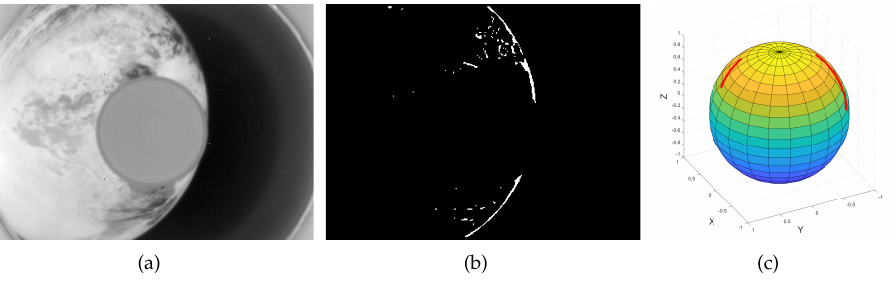
Figure 9. ( a ) Real Earth image. ( b ) Edge detected. ( c ) Actual horizon extracted.